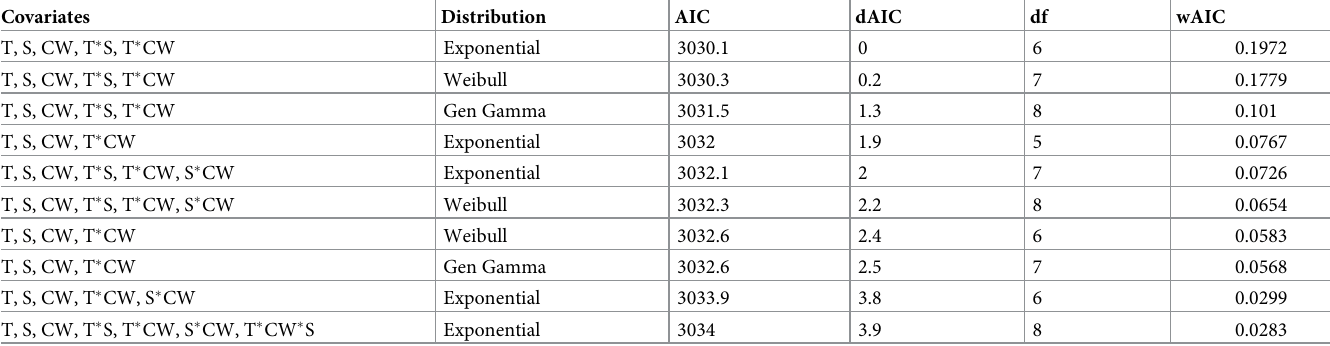
Table 2. Model selection criterion for the top 10 performing models using all of the data, including crabs from Bauer and Miller [52]. Covariates Distribution AIC dAIC df